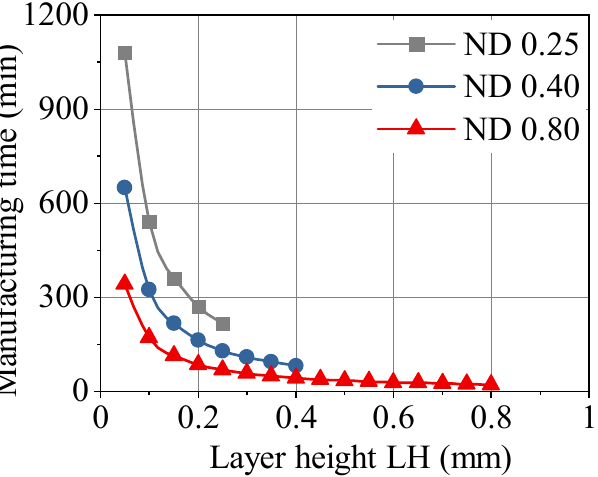
Figure 1. Manufacturing time vs. layer height depending on the nozzle diameter.